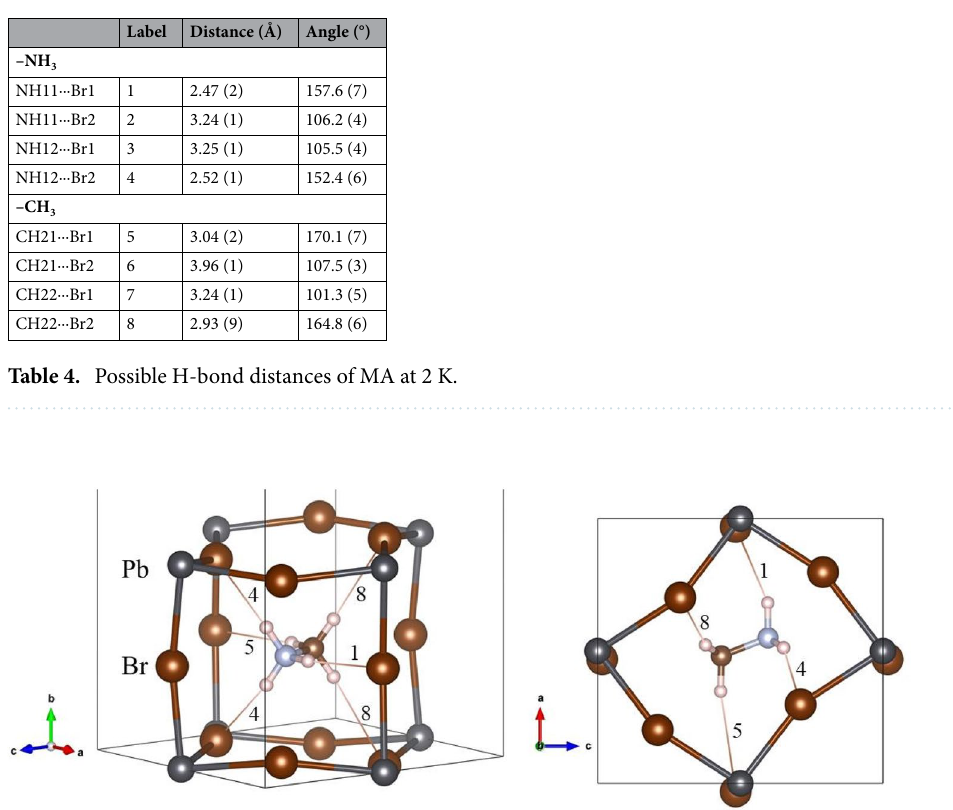
Figure 4. Two views of the orthorhombic crystal structure of MAPbBr 3 , highlighting the H-bond interactions with adjacent Br atoms approximately along [101] ( left ) and [010] ( right ) directions. The numbers correspond to the labels indicated in Table